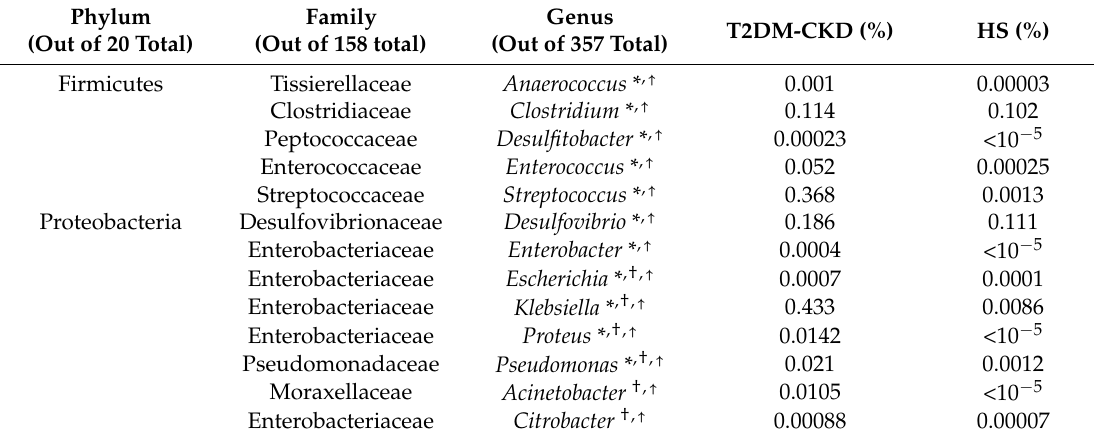
Table 3. The abundance of the gut microbiota associated with Trimethylamine (TMA) production from choline * and/or carnitine † identified in T2DM-CKD and healthy subjects (HS). Mann–Whitney U test showed significant difference of increased ( Ţ ) abundance of OTUs in the two groups, p < 0.05.